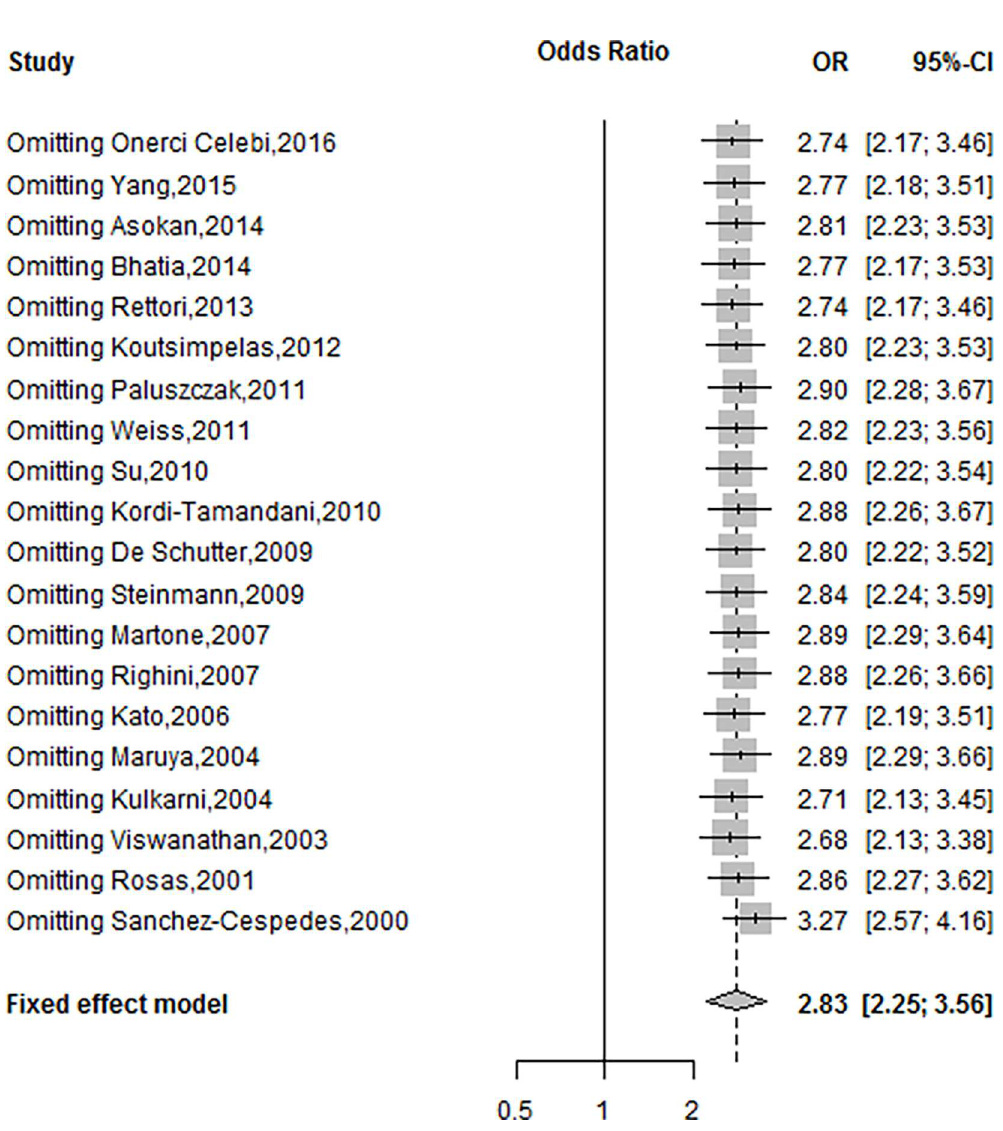
Fig 3. Sensitivity analysis of included studies under the fixed-effects